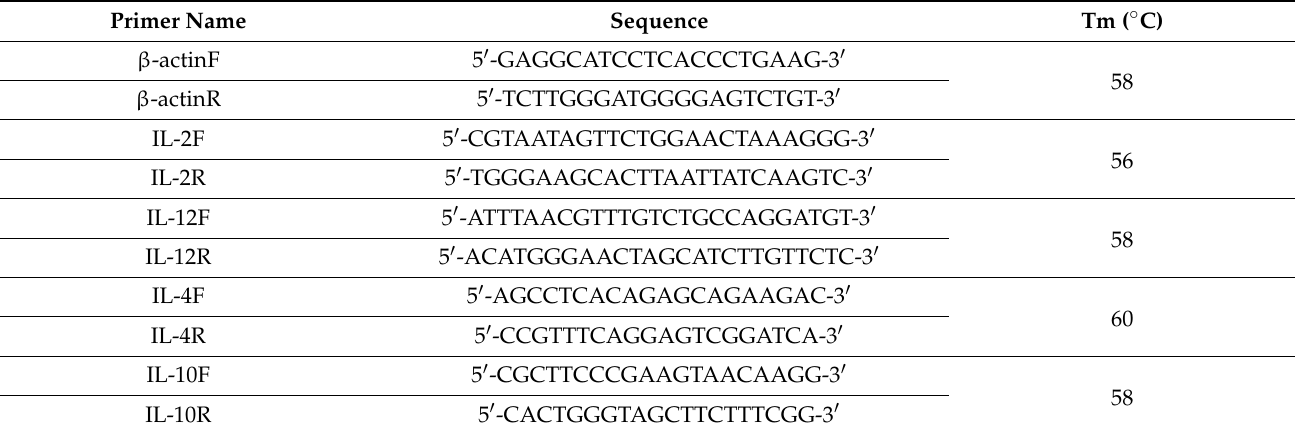
Table 2. RT-PCR primers for